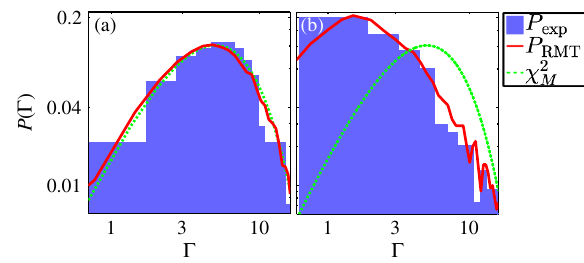
FIG. 3. (a) Experimentally extracted resonance-width Γ Þ (solid curve) for (a) d ¼ 1 and (b) d ¼ distribution P exp ð 29 , compared with numerically computed densities P from random-matrix-theory analysis (solid line) and with a χ 2 distribution (dashed line).